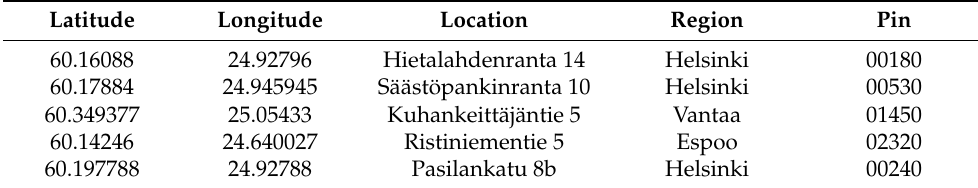
Table 4. Home charging hotspots for Helsinki [105].